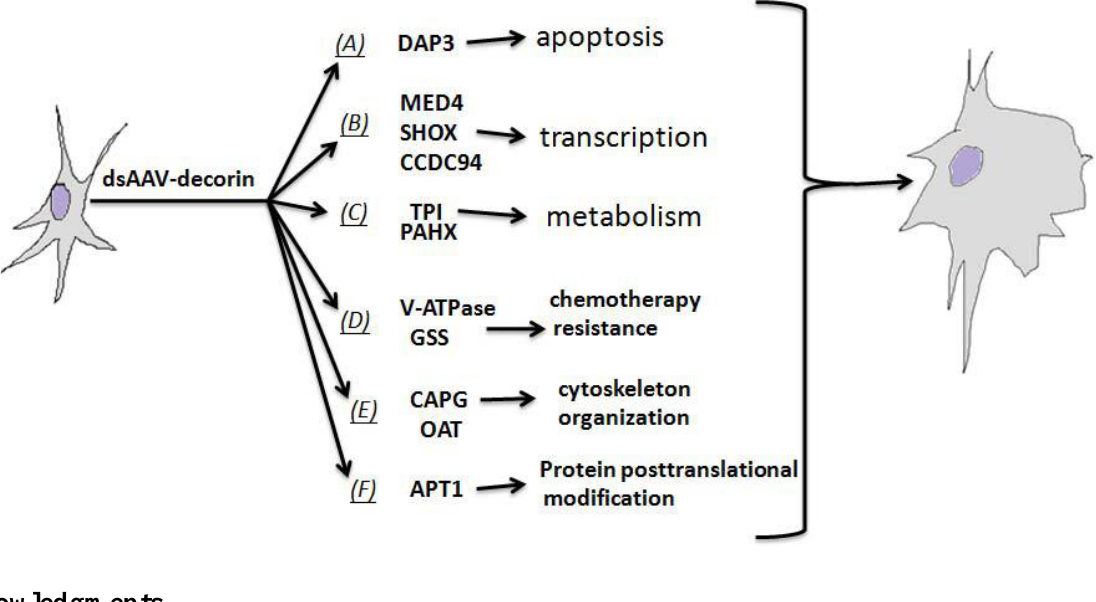
Figure 7. Schematic diagram of the multiple biochemical mechanisms evoked by dsAAV-decorin in U87MG cells. Potential effects of dsAAV-decorin on apoptosis ( A ); transcription ( B ); metabolism of glucose and lipid ( C ); chemotherapy resistance ( D ); cytoskeleton organization ( E ); and protein posttranslational modification ( F ) were summarized based on published